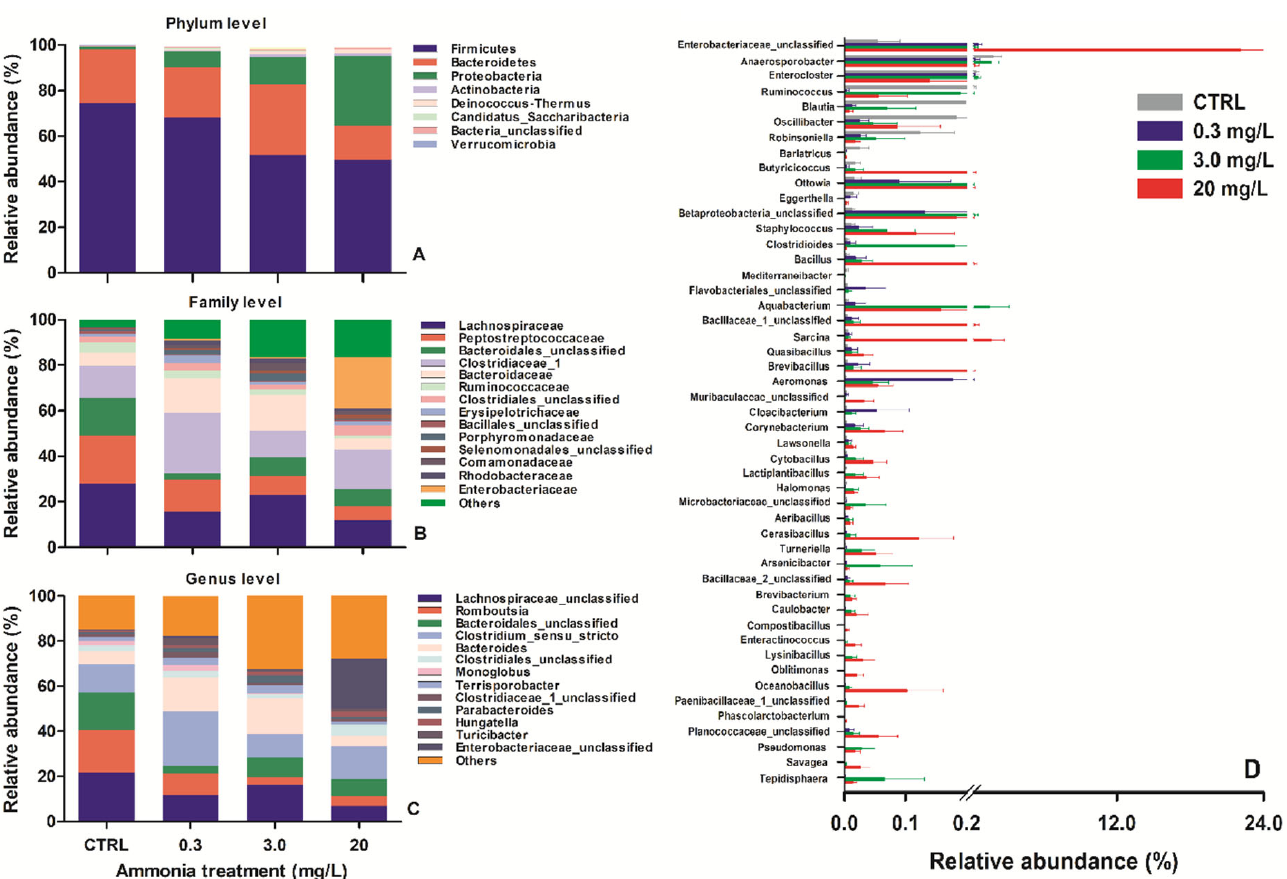
Figure 3. Relative abundance of the gut microbiota at the phylum ( A ), family ( B ), and genus ( C ) levels, and significantly changed bacterial genera ( D ) in different treatment groups of Trachemys scripta elegans